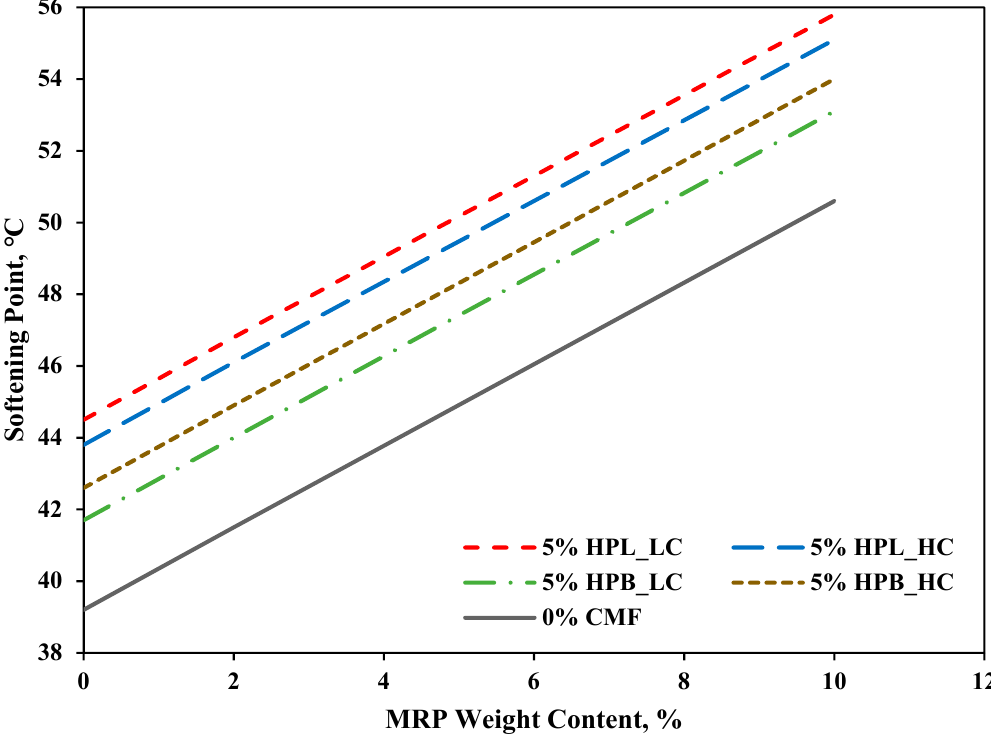
Figure 6. Effect of MRP content and CMF type on softening point at 0% and 5% CMF content. The penetration depth (PD) at 25 °C and softening point (SP) of unmodified asphalt were found to be 47.7 (units 0.1 mm) and 39.3 °C, respectively. The addition of MRP and/or CMF to asphalt significantly modified its penetration depth and softening point characteristics. With the increase in MPR and/or CMF content, penetration depth decreased, whereas the softening